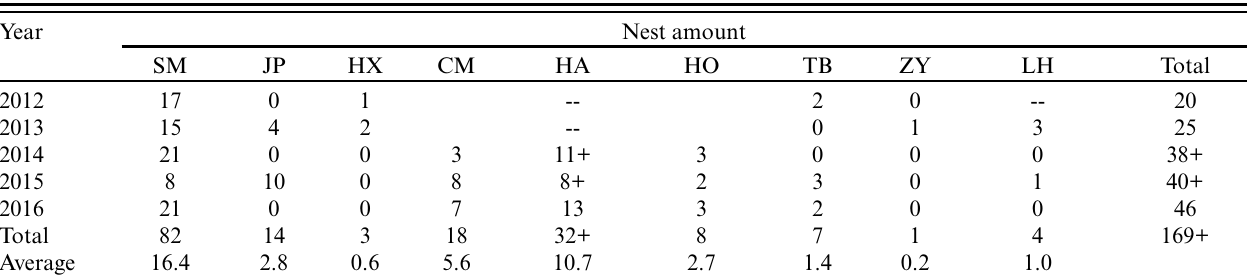
Table 1 . Numbers of nests in nine breeding sites of the Blue-crowned Laughingthrush ( Garrulax courtoisi ) in Wuyuan, Jiangxi, 2012– 2016.